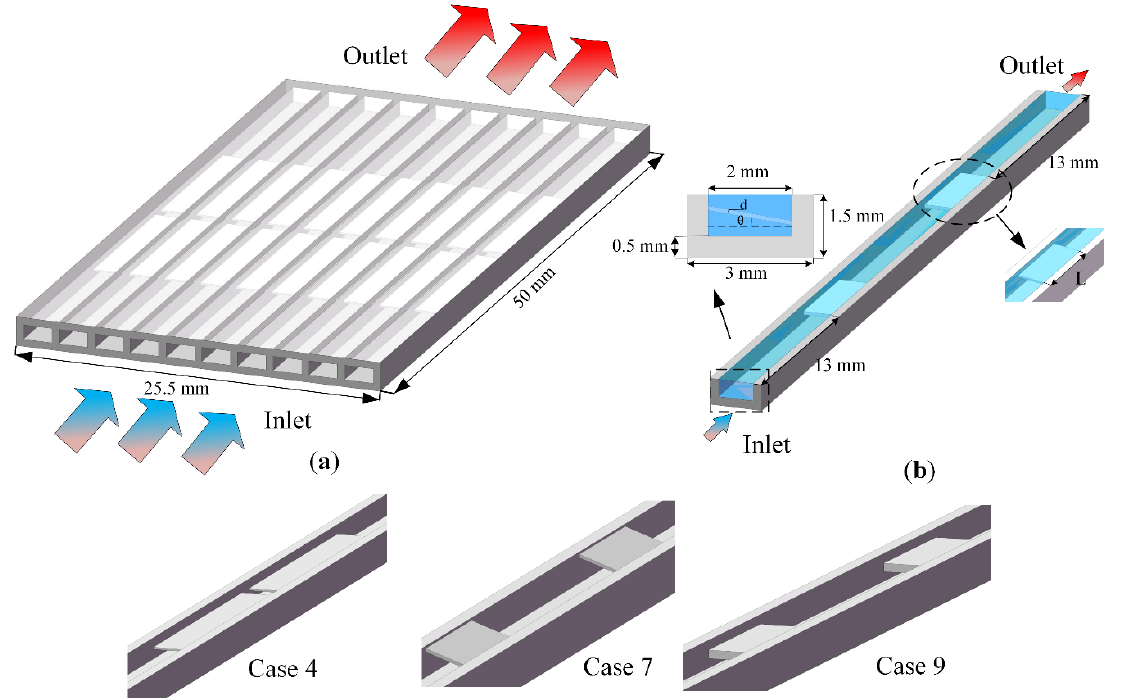
Figure 1. Schematic diagram of microchannel heat sink. ( a ) Overall microchannel structure; ( b ) microchannel heat sink in the computational domain.